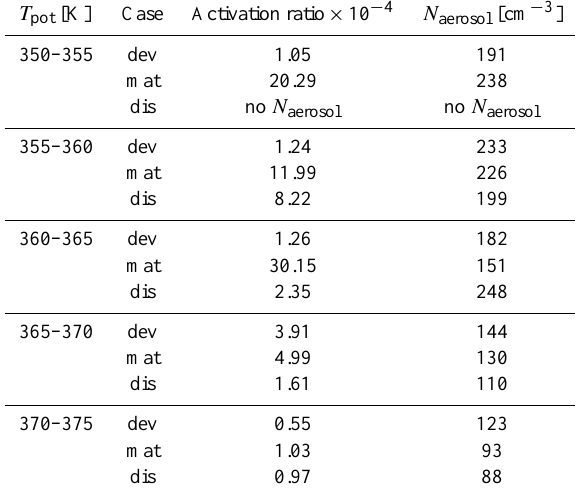
Table 2. Averages of activation ratio estimate and aerosol number concentrations for the different Hector stages and altitude bins as in Fig. 7. Note that aerosol measurements are not available for all given size